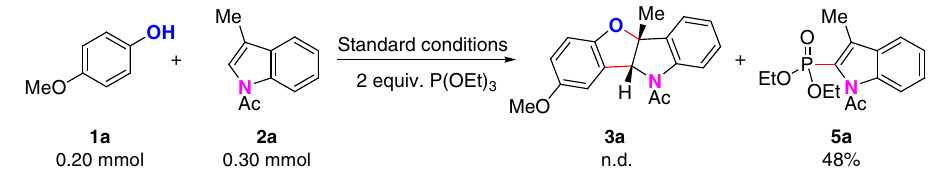
Fig. 7 Radical trapping experiment. Radical trapping experiment by P(OEt) 3